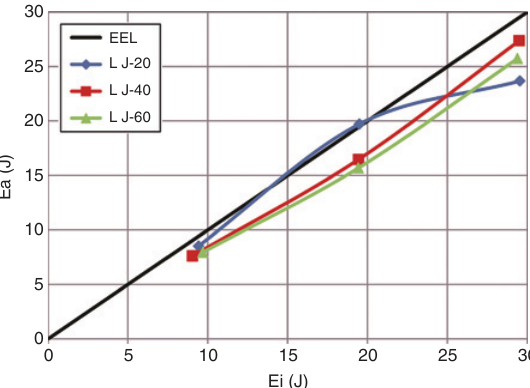
Figure 2 Three-point bending test after impact of the composite single-lap joints. Figure 3 EPD diagram of composite single-lap